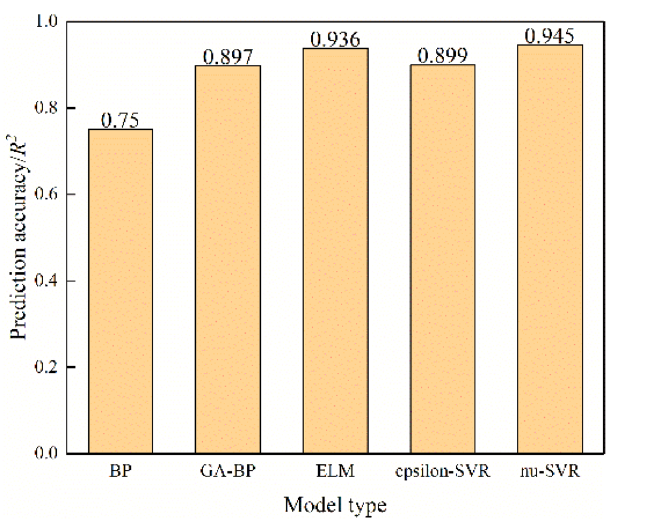
Figure 9. Model prediction